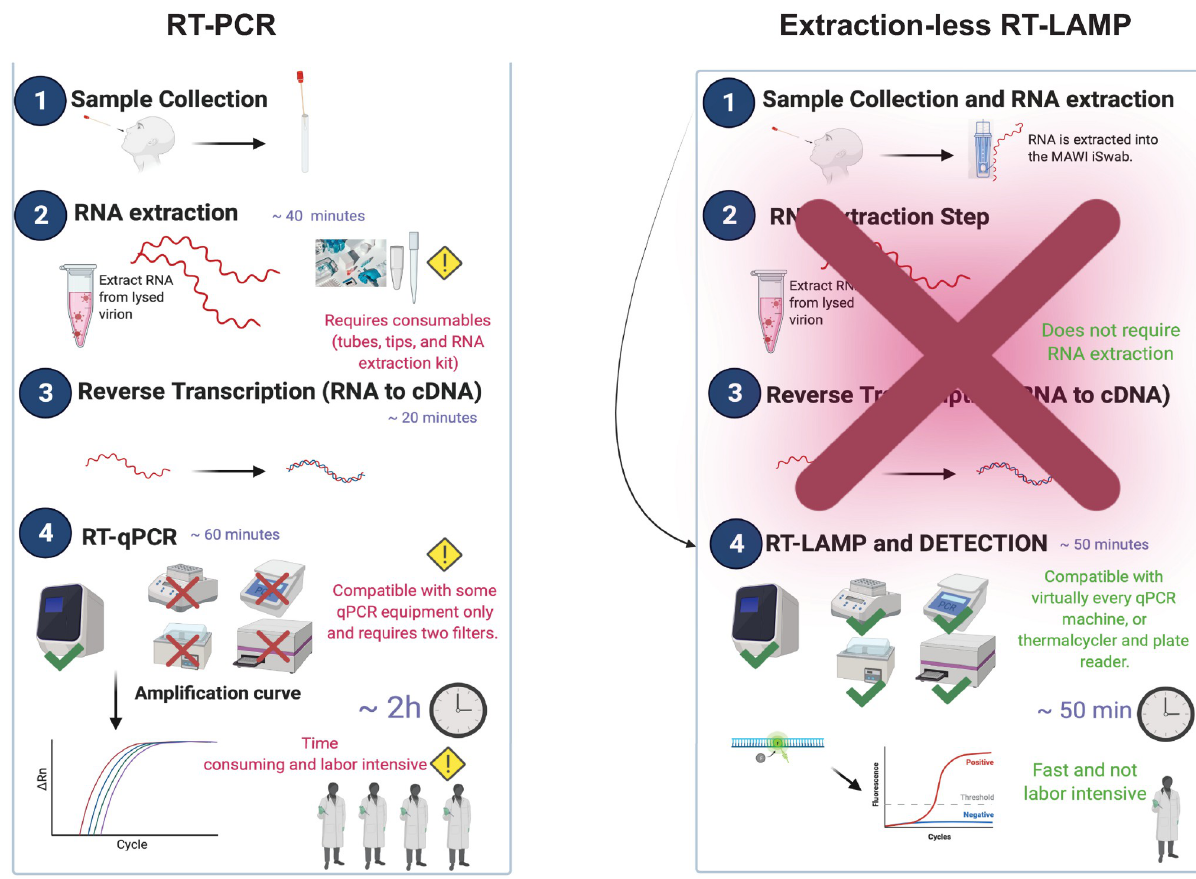
Fig 4. RT-PCR versus extraction-less RT-LAMP